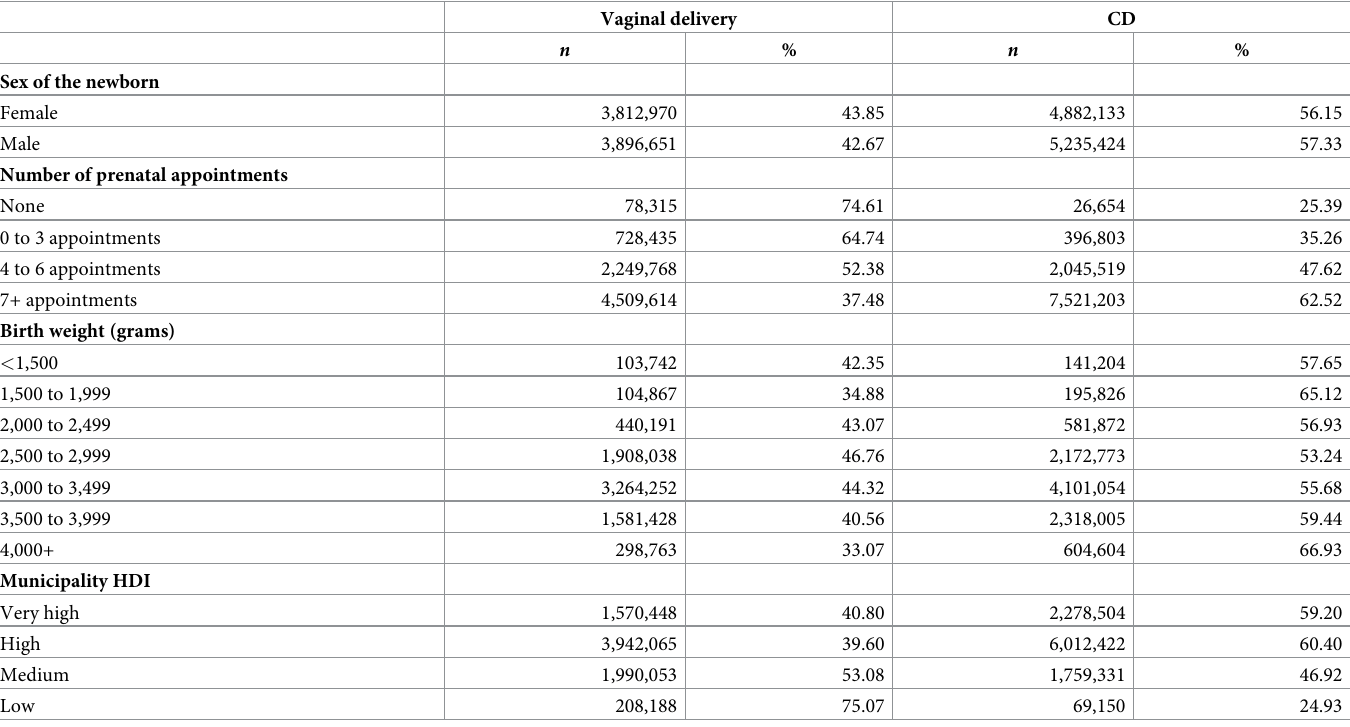
groups was less than 0.07 on all covariates (Tables B–D in S2 Text). The coefficients of the pro- pensity score models are shown in Table E in S2 Text, and the distribution of scores is shown in S1